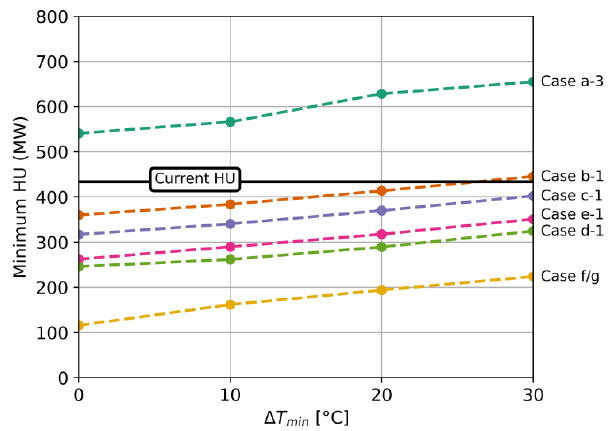
Figure 9. Hot utility targets for cases with different levels of process-to-process aggregation without indirect heat exchange through steam network (case a -3 without direct heat integration but with steam network is also shown for comparison).